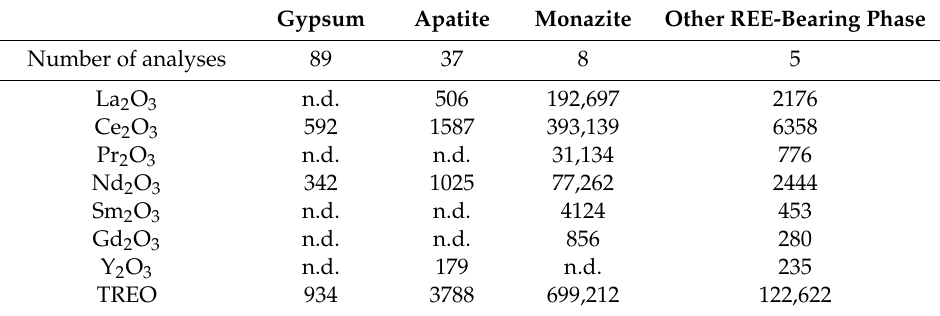
Table 10. The individual concentrations of REEs (measured by REOs) of the REE-bearing phases (mg / kg) *.